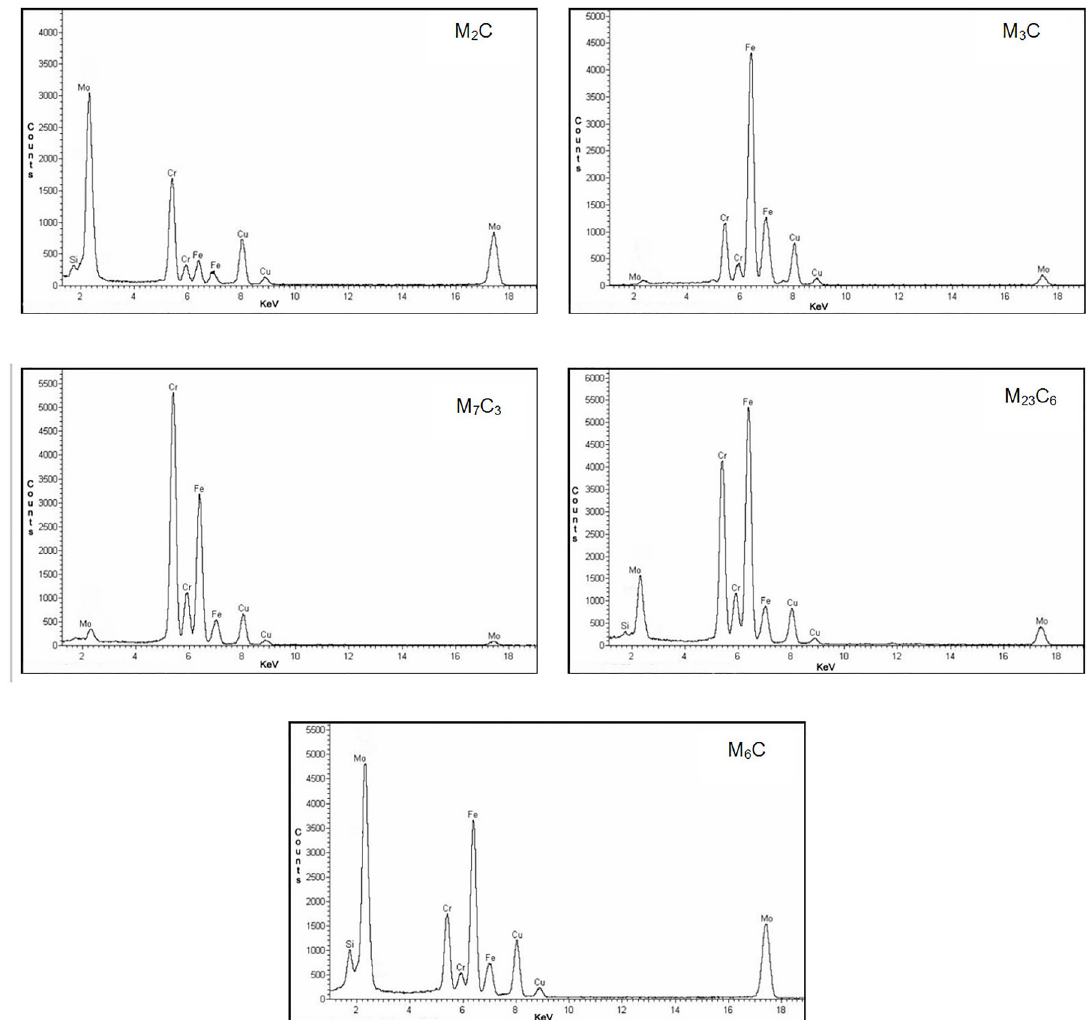
Figure 8: EDS spectra of the carbides identified in the ferrite-pearlite aged at 600°C for 1000 h sample. For the ferrite-pearlite